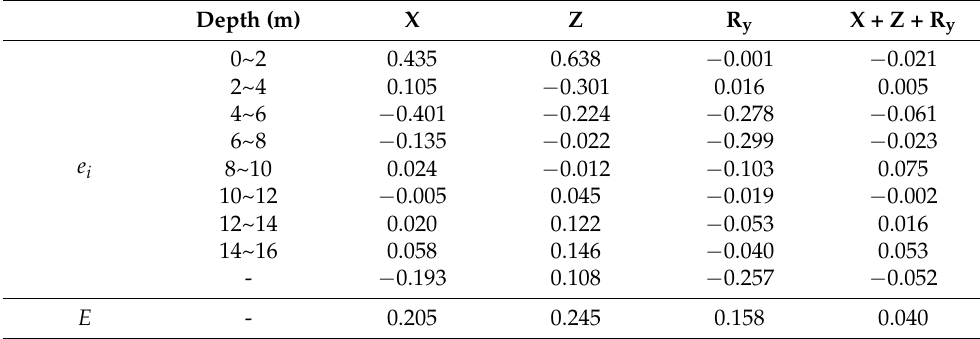
Table 4. Error of the inversion results using the radial (X), vertical (Z), rotational (R y ), and multi- component (X + Z + R y ) seismic